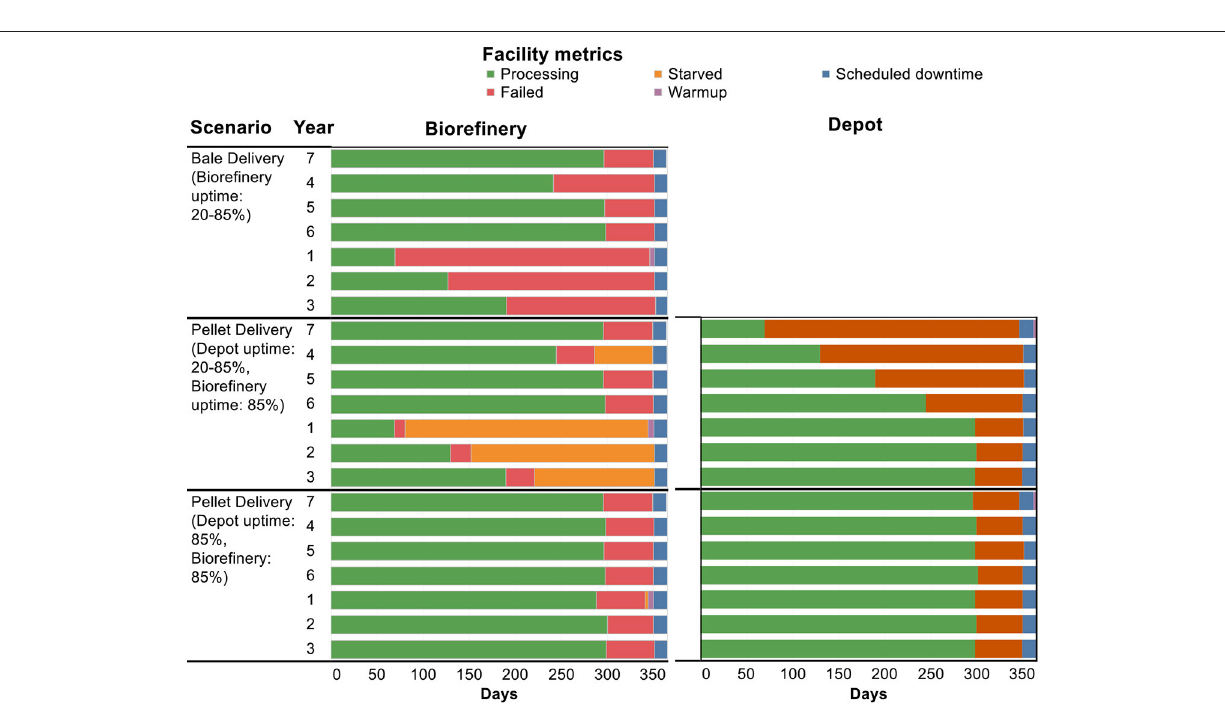
Frontiers in Energy Research |